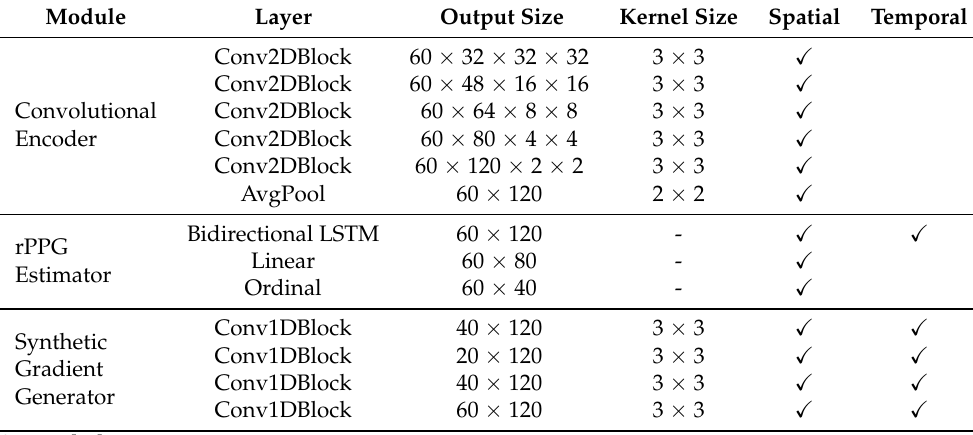
Table 2. Meta-rPPG network architecture.